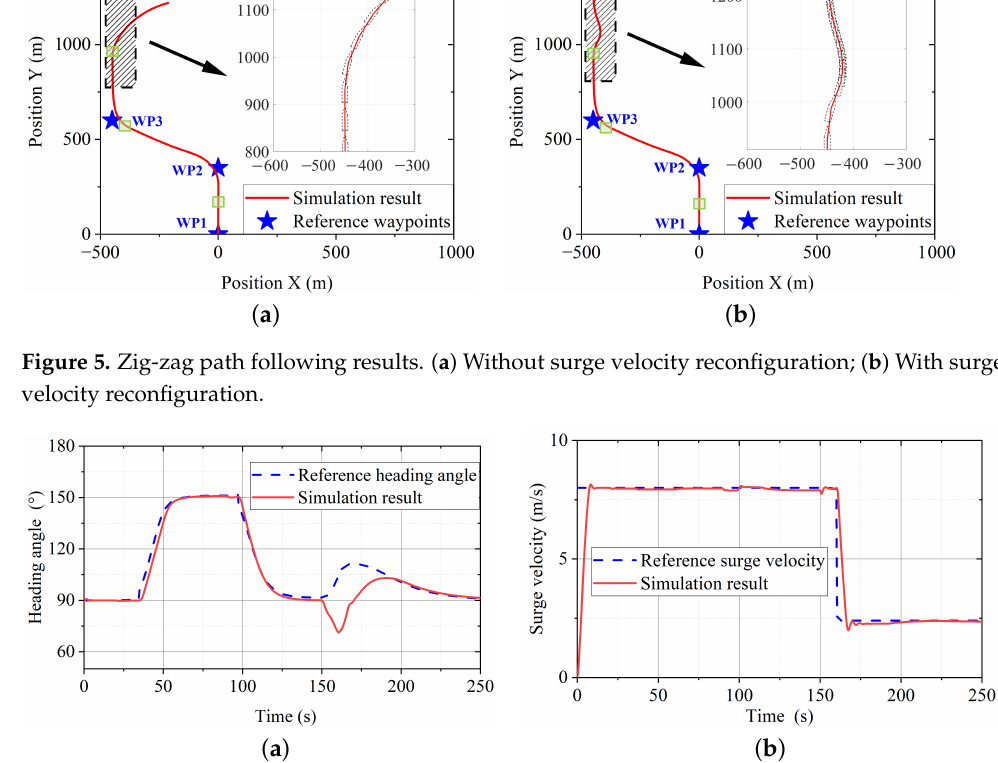
Figure 6. Measurements from navigation system in zig-zag path following. ( a ) Heading angle following; ( b ) Heading speed following.